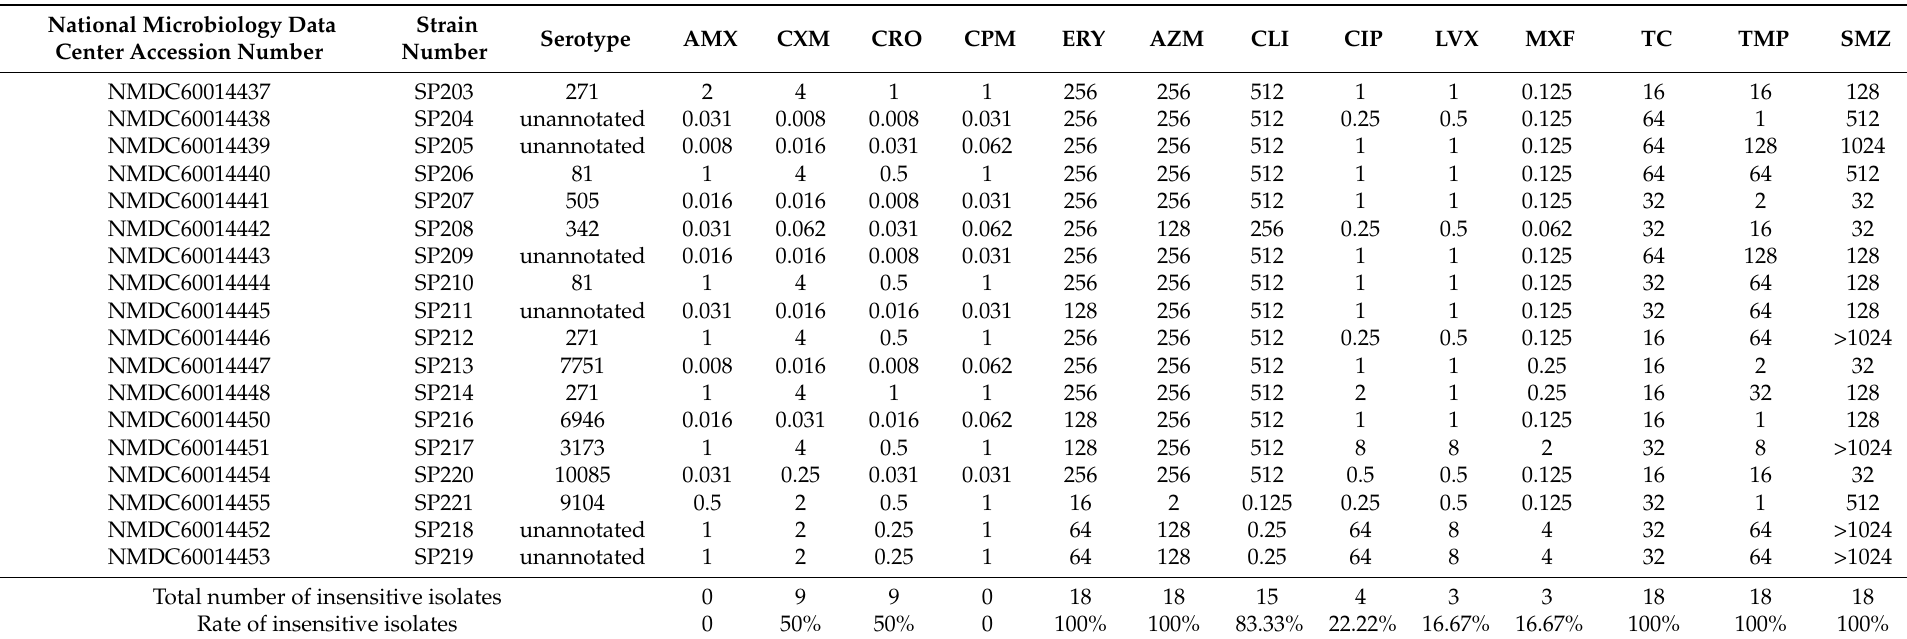
Table 1. Antibiotic susceptibility profiles of the clinical isolates in this study